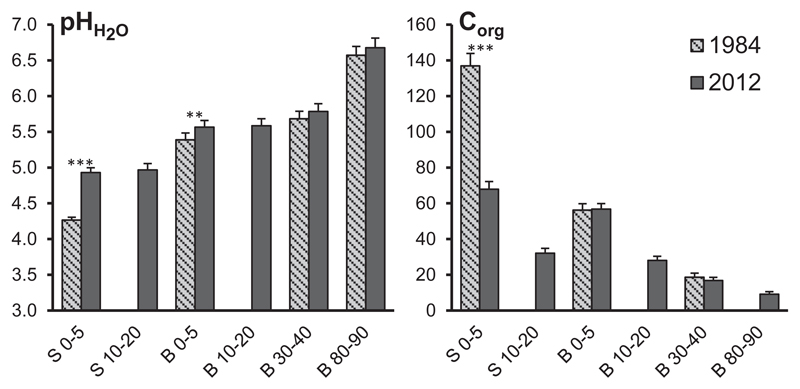
Mean soil pH (H2O) and Corg content (mg g−1) in different soil depths of the stemflow area (S 0–5 and S 10–20) and the between trees area (B 0–5, B 10–20, B 30–40 and B 80–90) at 97 beech stands in 1984 and 2012 (modified from Berger et al., 2016). Paired sample t-tests were performed to test significance of differences between the years 1984 and 2012 and only significant results are given as: **: p ≤ 0.01; ***: p ≤ 0.001. Error bars are ± S.E.